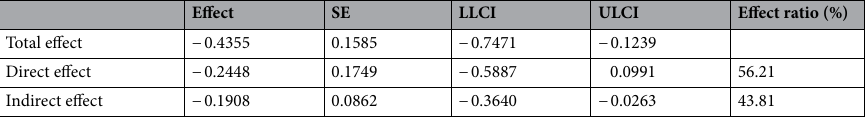
Table 5. Mediation results: the indirect effect of mindfulness on dental anxiety through rational